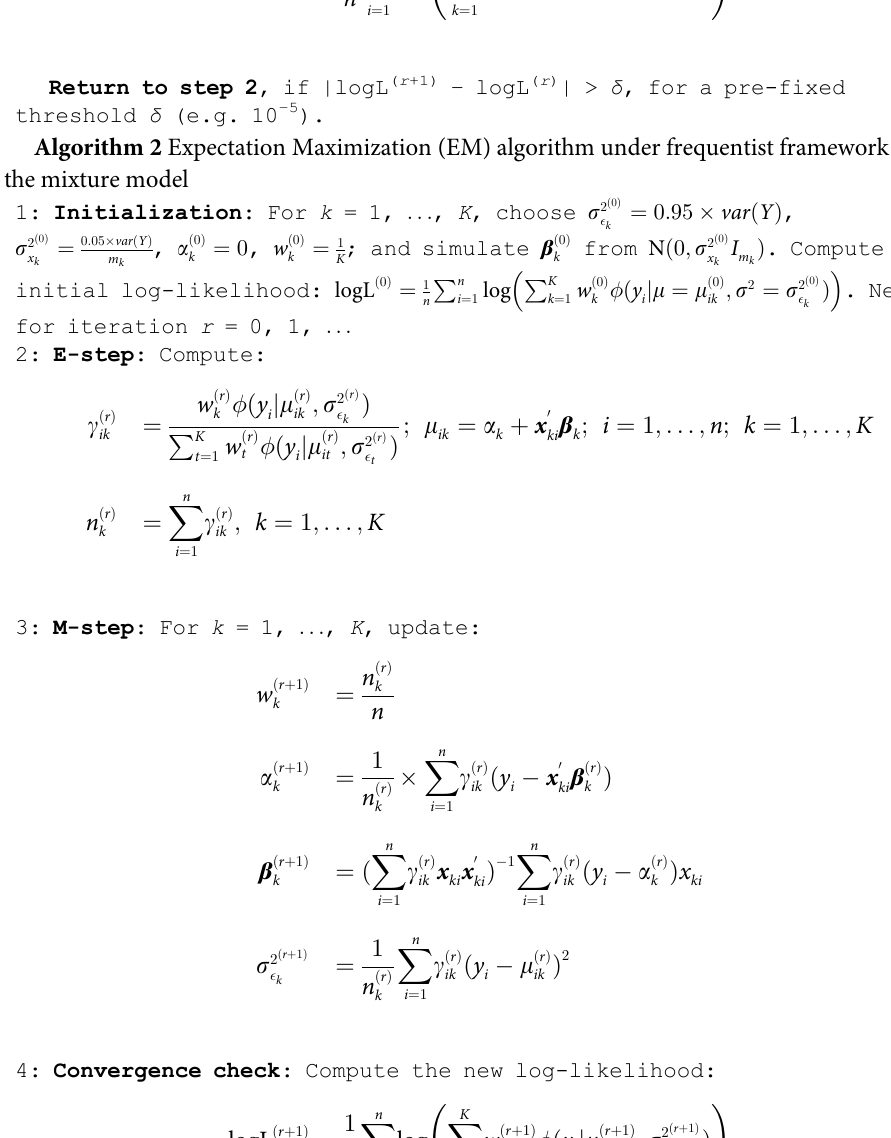
Algorithm 2 Expectation Maximization (EM) algorithm under frequentist framework of the mixture